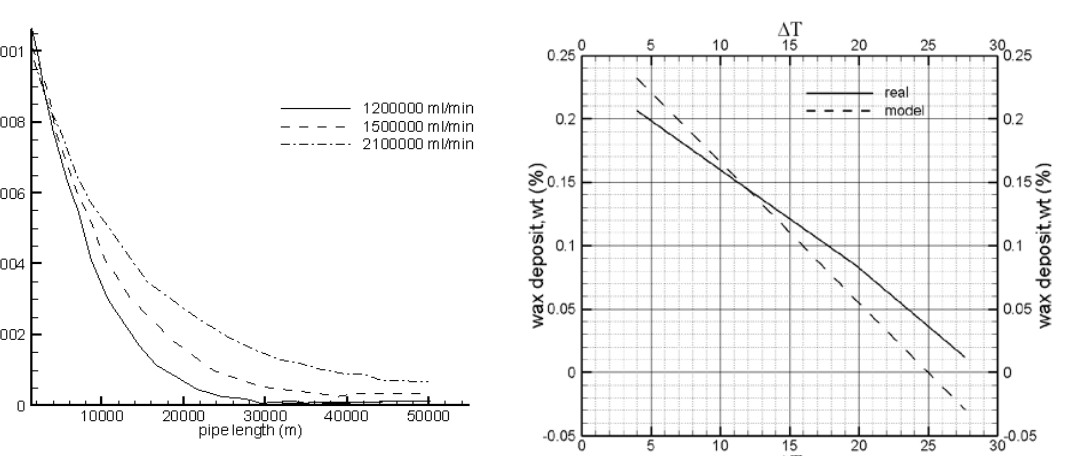
Figure 20 Comparison between real result and developed model for works by Kelechukwu et al.